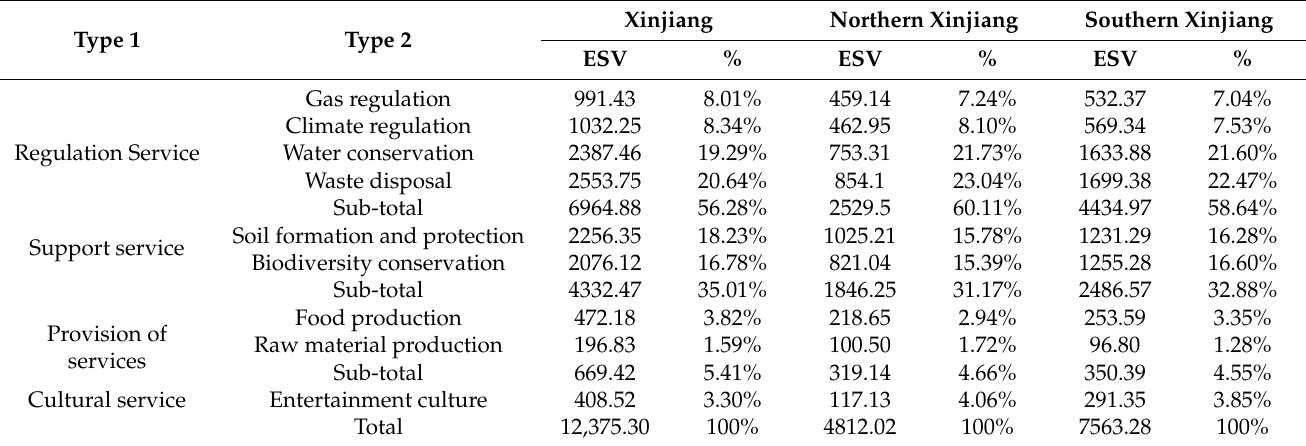
Table 5. Changes in the value of individual ecosystem services in various units in Xinjiang (10 8